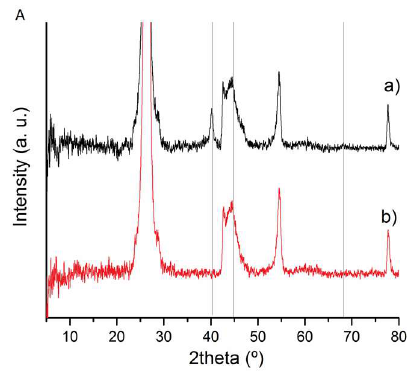
Figure 1. X-ray diffraction (XRD) patterns of the catalysts: ( a ) Pd IMP /CNF and ( b ) Pd SI /CNF.